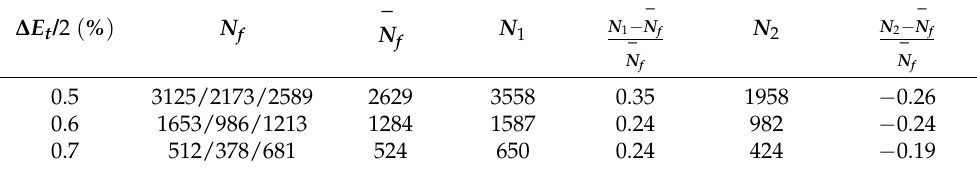
Table 4. Experimental LCF lives vs. the predicted LCF lives by using the existing method ( N 1 ) and proposed method ( N 2 ).